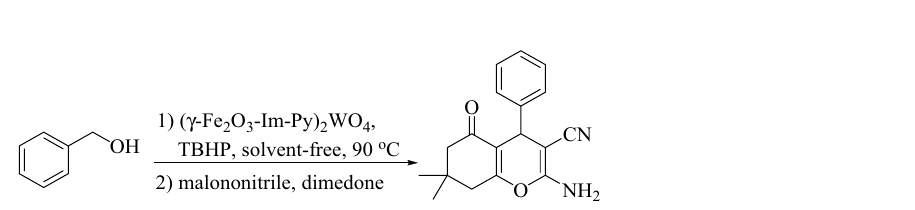
2 O 3 -Im-Py) 2 WO 4 (57